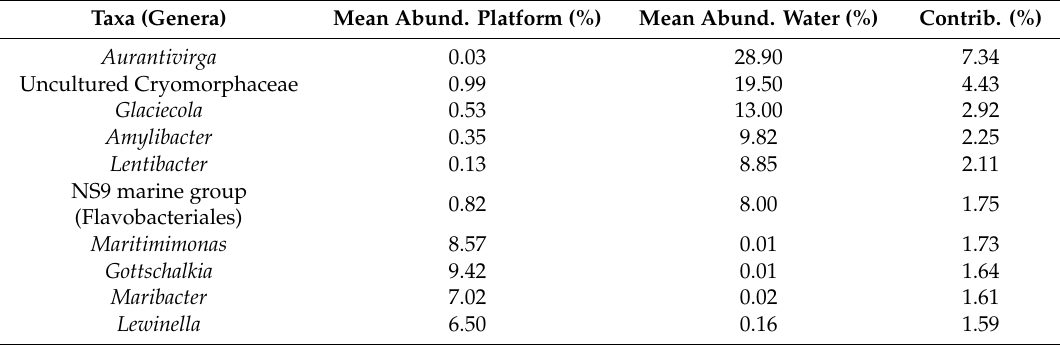
Table A2. SIMPER analysis results displaying top 10 genera responsible for the dissimilarity and the contribution percentage for that dissimilarity between water samples and biofouling samples from